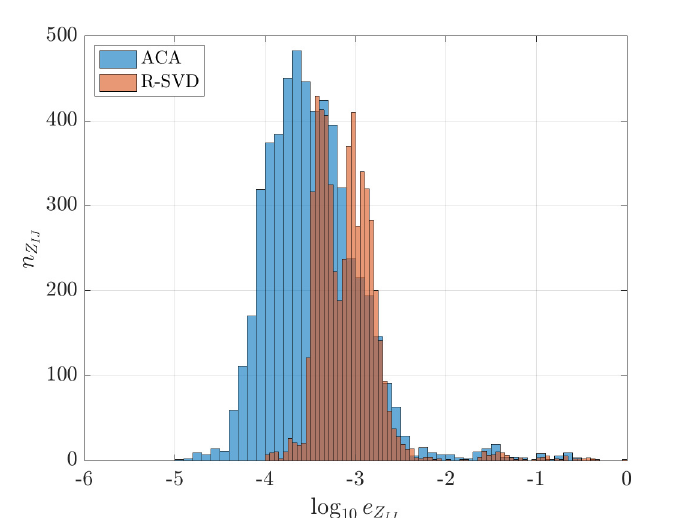
Figure 3. Compression error distribution for the double-layer matrix computed by the ACA and R-SVD algorithms: percentage compression error e Z for both algorithms is 10 − 3 , which corresponds to − 3 in abscissa.